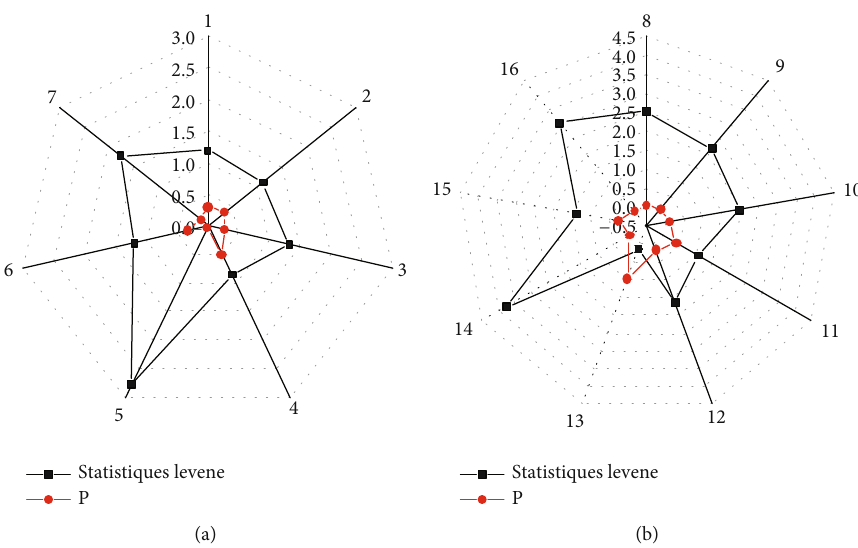
Figure 5: Homogeneity of variance between father ’ s education level and college students ’ mental health (1: autonomy; 2: environmental control; 3: personal growth; 4: positive relationships with others; 5: life goal; 6: self-a ffi rmation; 7: total score of PWB; 8: somatization; 9: obsessive-compulsive; 10: interpersonal relationship sensitivity; 11: depression; 12: antagonism; 13: scariness; 14: paranoia; 15: psychosis; 16: total score of